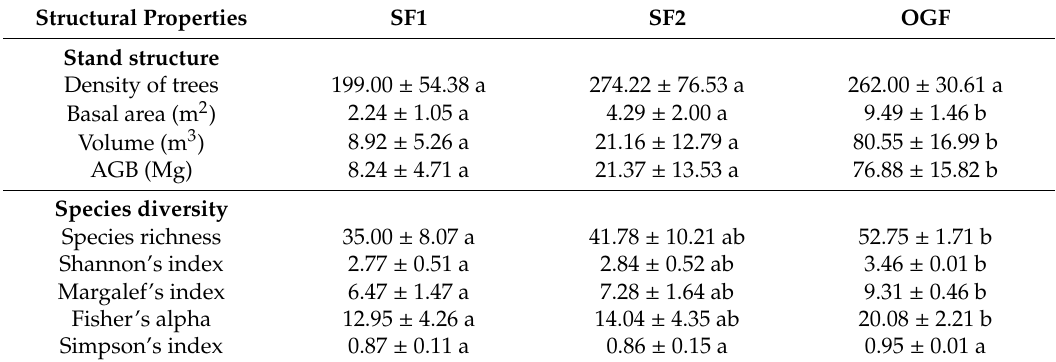
Table 1. Structural characteristics and species diversity of the three forest types, (Mean ± SD).